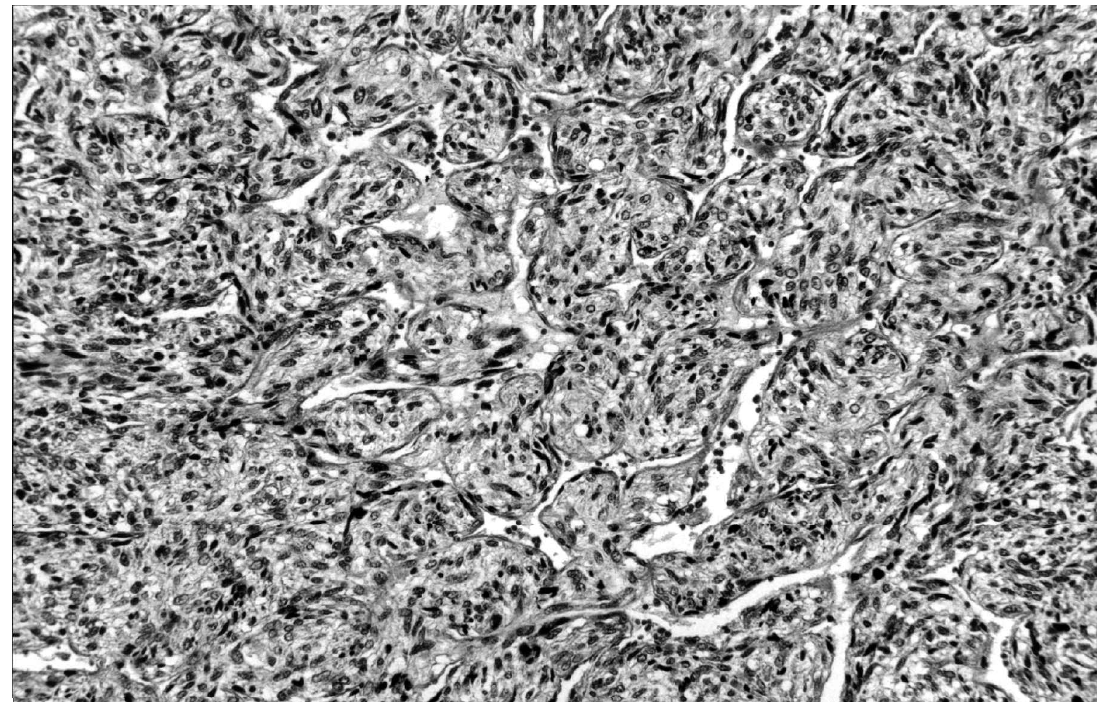
Fig. 2. Histological section of the tumor mass showing tightly packed spindle-like cells surrounding ramifying thin-walled endothelium- lined vascular channels with typical `antler’ or `staghorn’ con® guration (H & E, 180 3